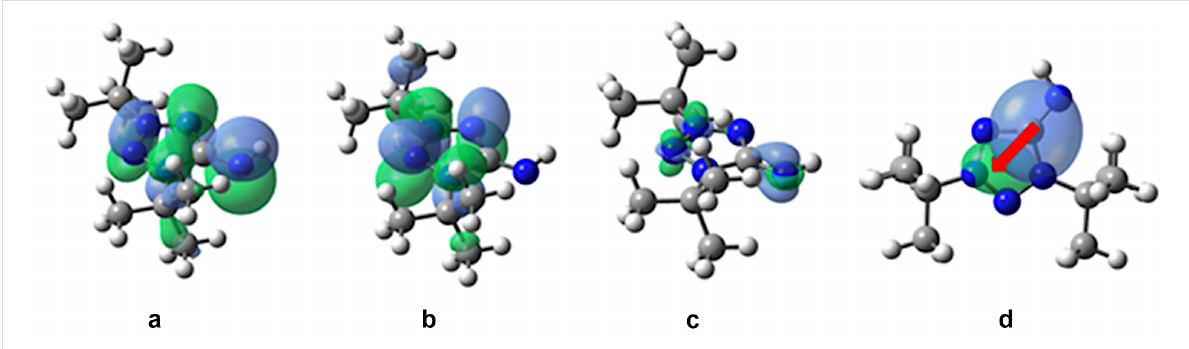
Figure 6: The calculated plots in n -hexane of a) HOMO, b) LUMO, c) electron density difference between the S 1 and S 0 states, and d) the S 0 → S 1 CT. Green (blue) regions (for c and d) indicate an increase (decrease) in the electron density upon the electronic transition. The red arrow shows the charge